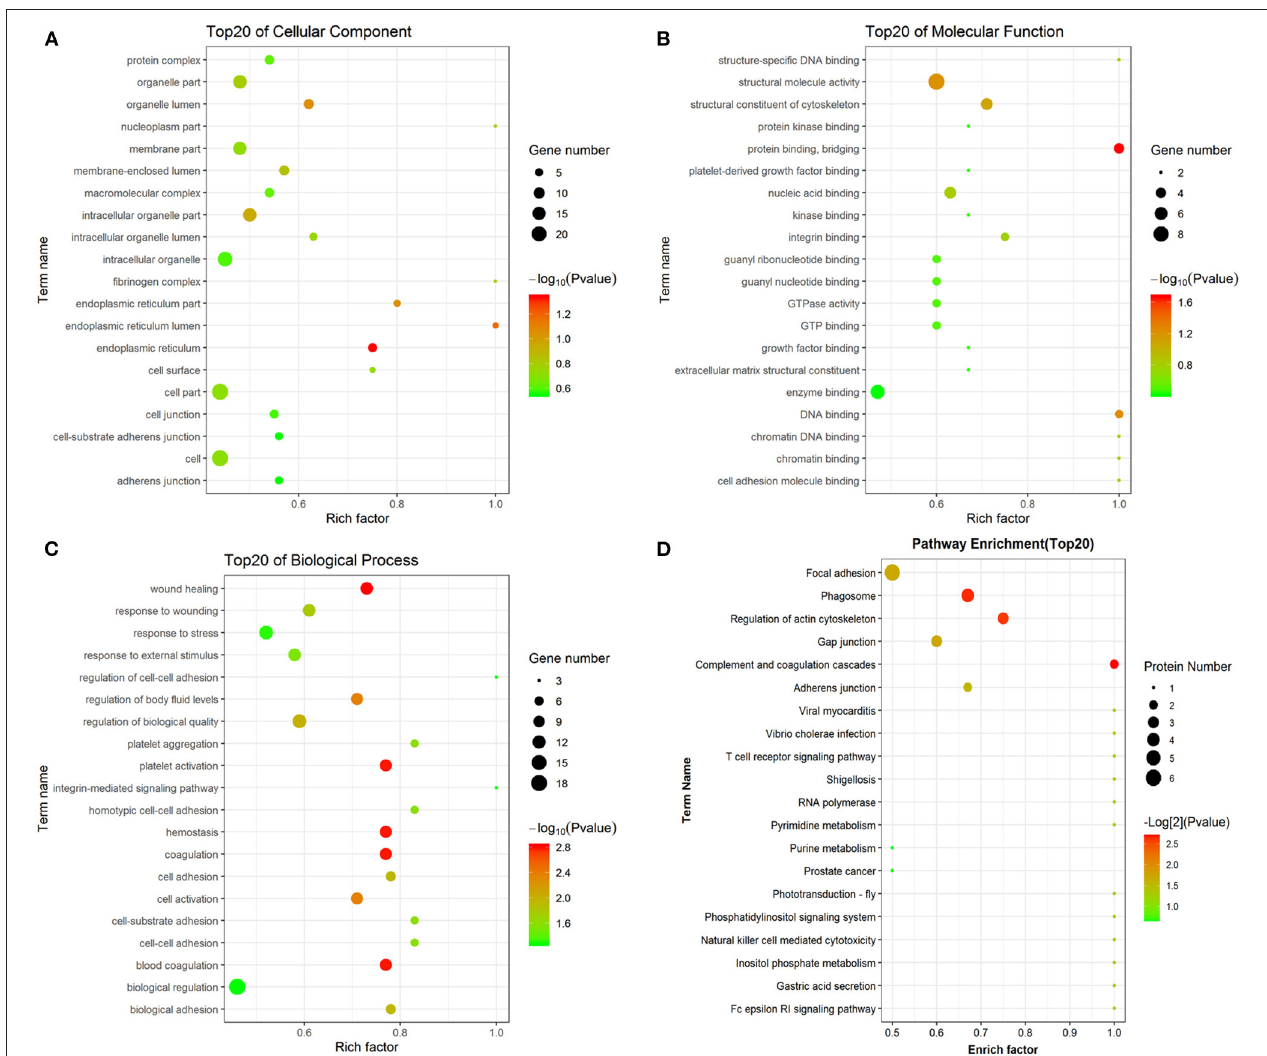
FIGURE 4 | GO and pathway analyses of precursor proteins of differentially expressed peptides. The cellular component categories (A) . The molecular function categories (B) . The biological process categories (C) . Pathway analysis (D) .